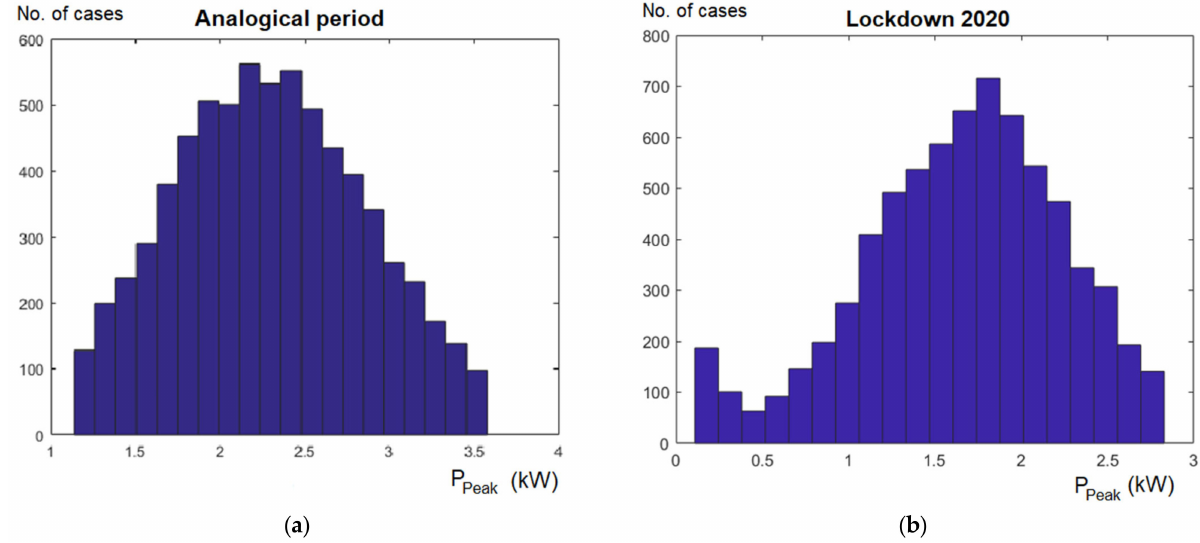
Figure 2. Histograms of the active power peaks registered in users during ( a ) 2018 and ( b ) the lockdown in 2020.